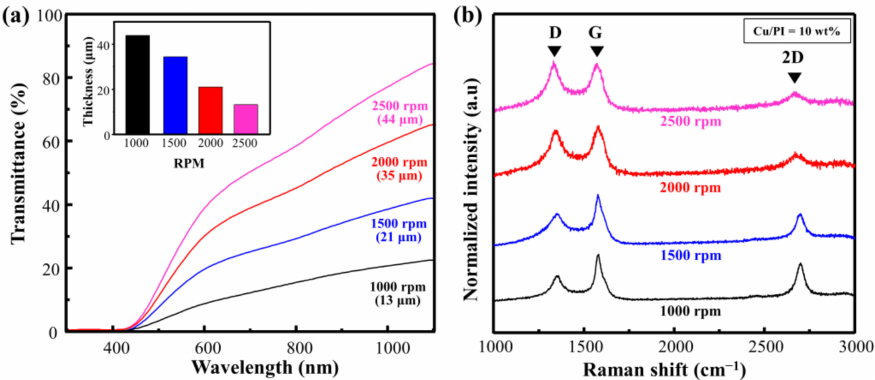
Figure 4. ( a ) Vis–NIR spectra of spin-coated Cu@PI film and ( b ) Raman spectra of Cu@LSC with different spin-coating conditions.